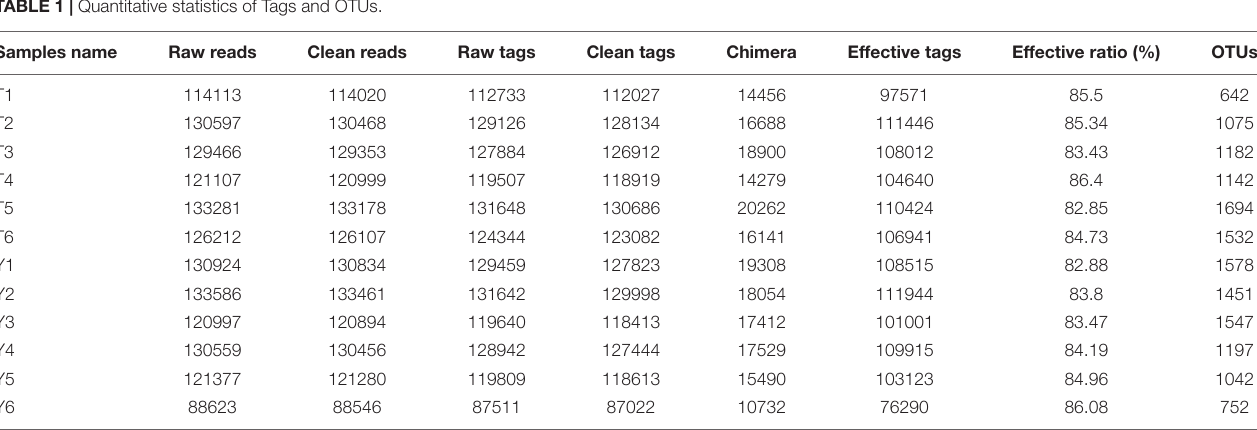
FIGURE 1 | Morphological observation of colon in Tibetan pigs and Yorkshire pigs under different magnifications. (A1–A3) Colon and intestinal sections of Tibetan pigs; (B1–B3) Colon and intestinal sections of Yorkshire pigs. TABLE 1 | Quantitative statistics of Tags and